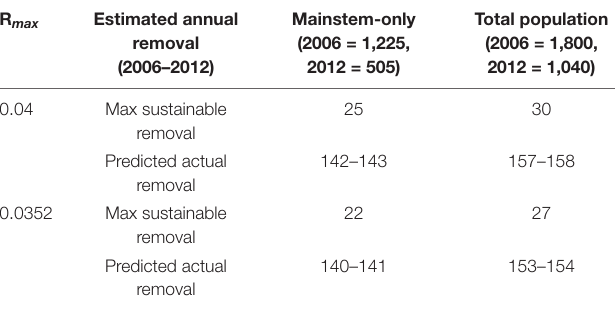
TABLE 4 | Estimated annual removals in logistic model from mainstem-only and total porpoise populations required to maintain stable 2006 population size (maximum sustainable removal) or result in observed 2012 population size (predicted actual